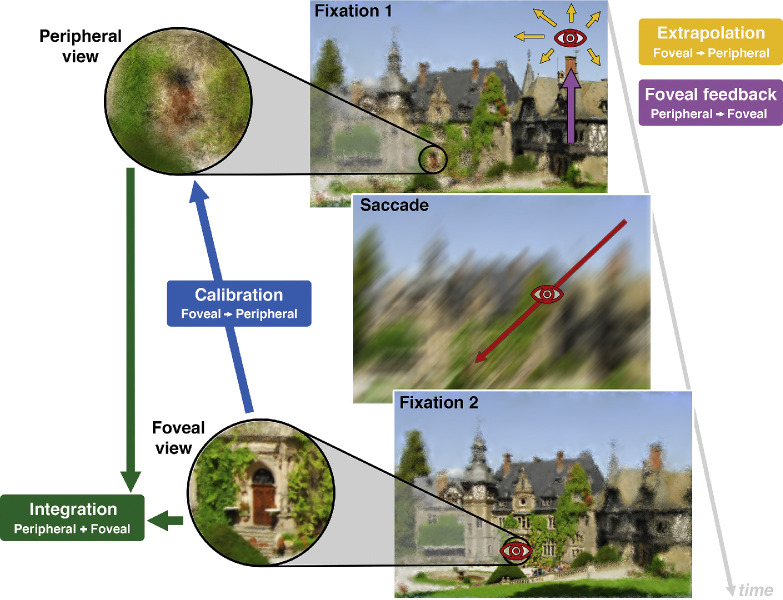
Schematic illustration of interactions between peripheral and foveal vision. The images illustrate differences between peripheral and foveal vision and the typical sequence of transsaccadic vision. Yellow, purple, green, and blue arrows indicate the direction of information flow. During fixation, peripheral vision is characterized by uncertainty in position (illustrated by spatial disarray using the Eidolon Factory (Koenderink et al., 2017); the degradation is overemphasised for the purpose of illustration), reduced spatial resolution, and increased crowding. Foveal appearance is extrapolated towards the periphery (yellow arrows; Extrapolation of foveal information to the periphery) and peripheral object recognition is supported by foveal feedback processing (purple arrow; Foveal feedback signals supporting peripheral object recognition). A saccadic eye movement (red arrow) brings an object of interest (here the castle door) to the fovea. During the saccade, vision is impaired (Dodge, 1900; for reviews see Matin, 1974; Volkmann, 1986; Wurtz, 2008; Binda & Morrone, 2018) by several factors, such as motion blur (Burr & Ross, 1982; but see Castet & Masson, 2000), masking due to the clear pre- and postsaccadic image (Matin, Clymer, & Matin, 1972; Campbell & Wurtz, 1978; Duyck et al., 2016), and active reduction of contrast sensitivity (e.g. Volkmann, 1962; Burr, Morrone, Ross, 1994; Diamond, Ross, Morrone, 2000). Differences between peripheral and foveal appearance might be compensated by transsaccadic re-calibration (blue arrow; Re-calibration of peripheral and foveal vision). Information from successive fixations might be stitched together by transsaccadic integration (green arrows; Transsaccadic integration of peripheral and foveal information).